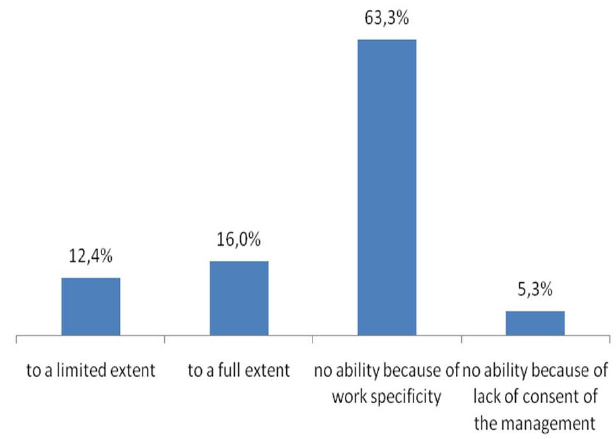
Figure 3. Ability to work remotely during the